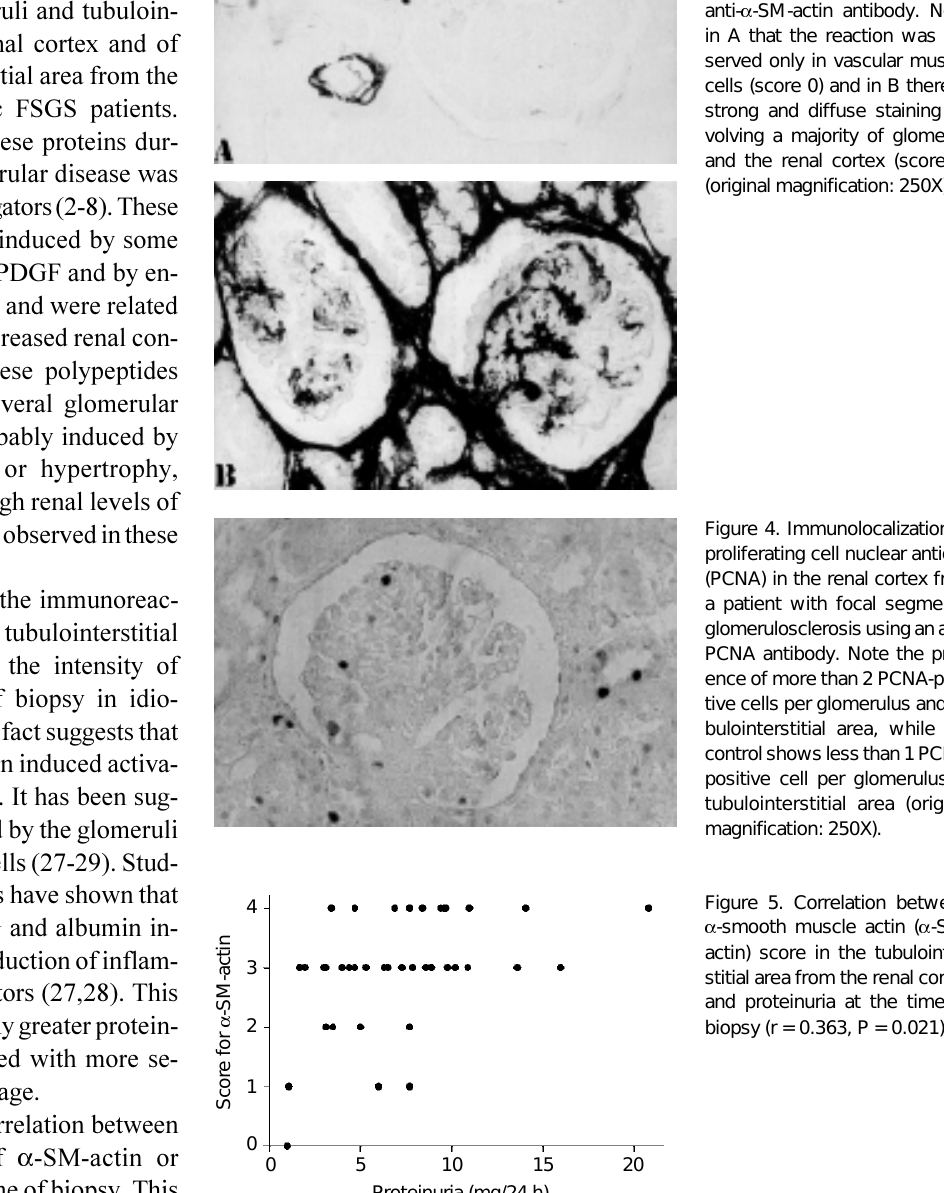
Figure 3. Immunolocalization of a -smooth muscle actin (a -SM- actin) in the renal cortex from a control individual (A) and from a patient with focal segmental glomerulosclerosis (B) using an anti- a -SM-actin antibody. Note in A that the reaction was ob- served only in vascular muscle cells (score 0) and in B there is strong and diffuse staining in- volving a majority of glomeruli and the renal cortex (score 4) (original magnification: 250X).